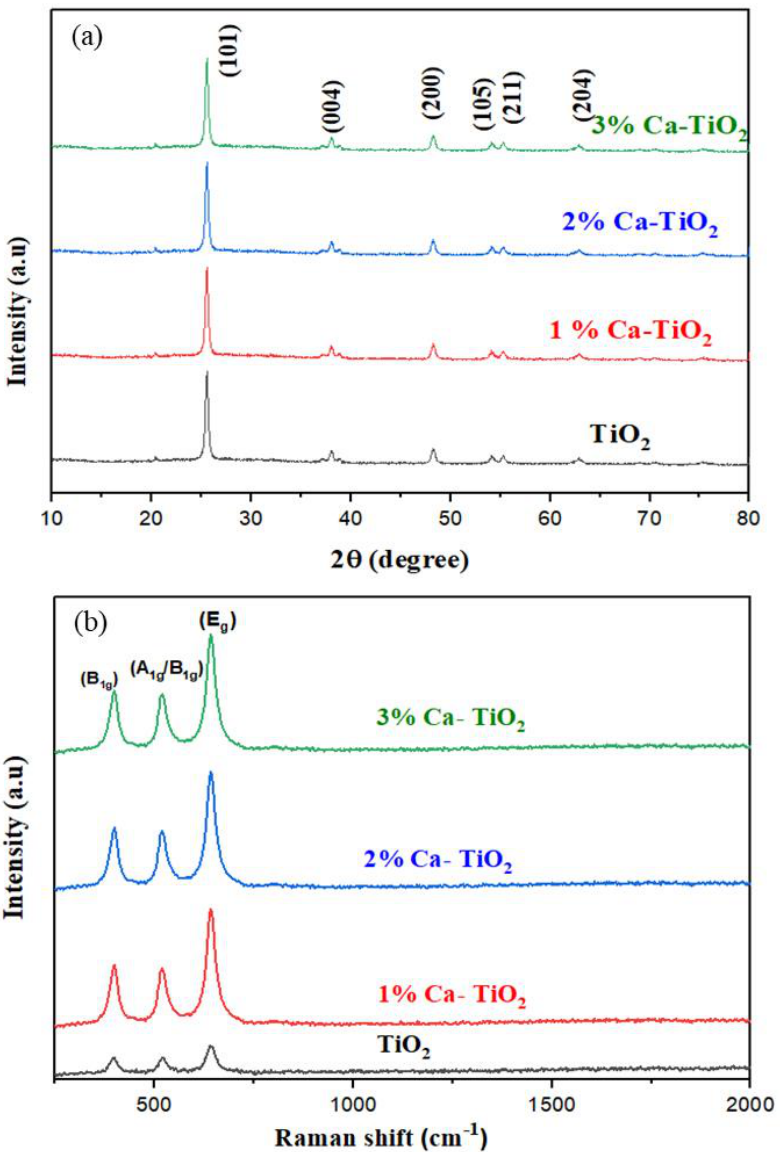
Figure 2. ( a ) XRD pattern for undoped TiO 2 , 1 wt%, 2 wt%, and 3 wt% Ca-doped TiO 2 ; ( b ) Raman spectra of undoped TiO 2 , 1 wt%, 2 wt%, and 3 wt% Ca-doped TiO 2.